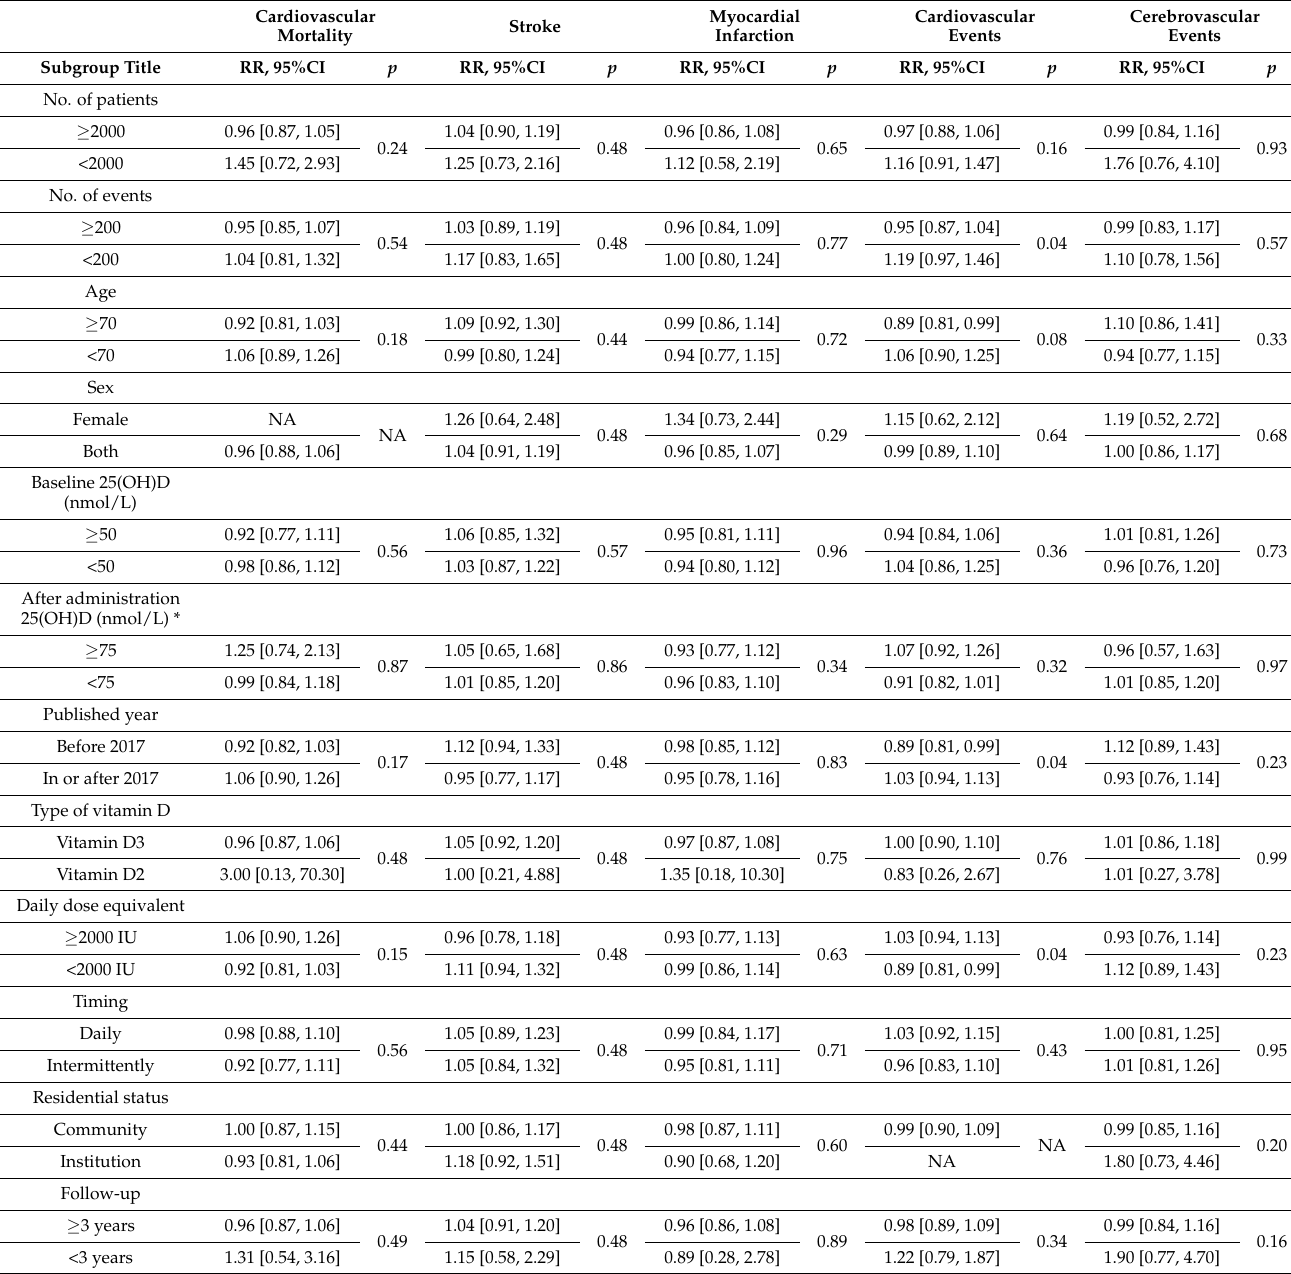
Table 3. Subgroup analysis of the effect of vitamin D supplementation for